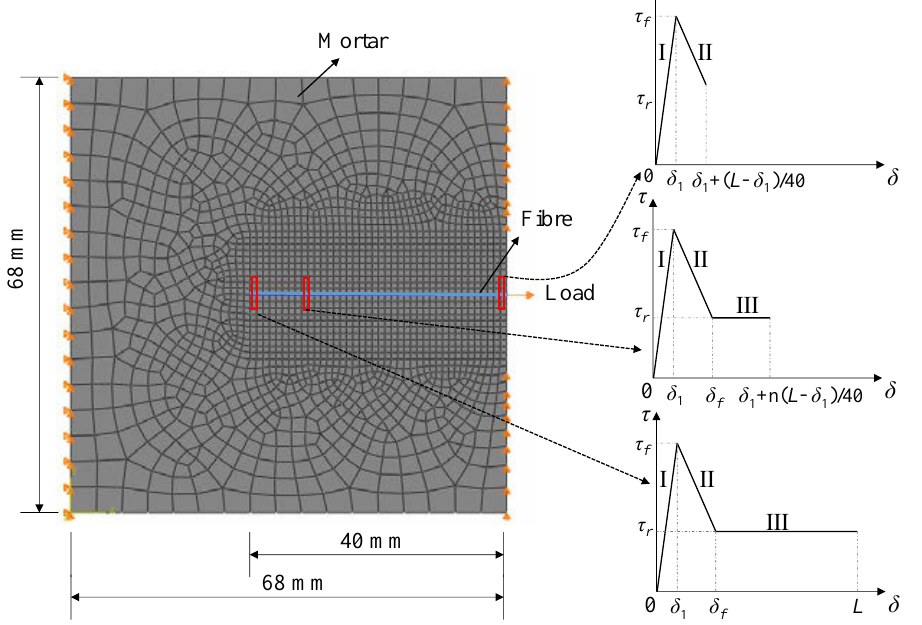
Table 3. Material parameters in FE simulations.